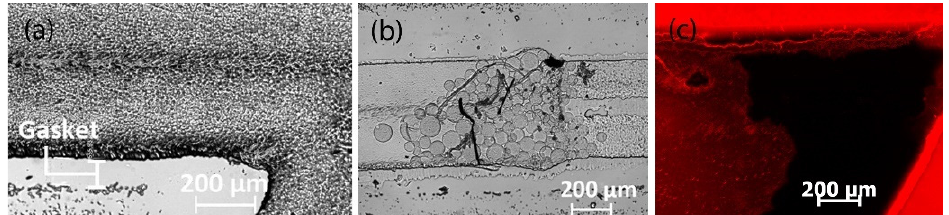
Figure 15. Microfluidic chip replicated from a Form 2 printed casting mold including a gasket. ( a ) Gasket between the channel (upper part) and leaky bond of glass and PDMS. ( b ) Sieve with retained particles. ( c ) Leakage around channels visualized with fluorescent rhodamine B solution.